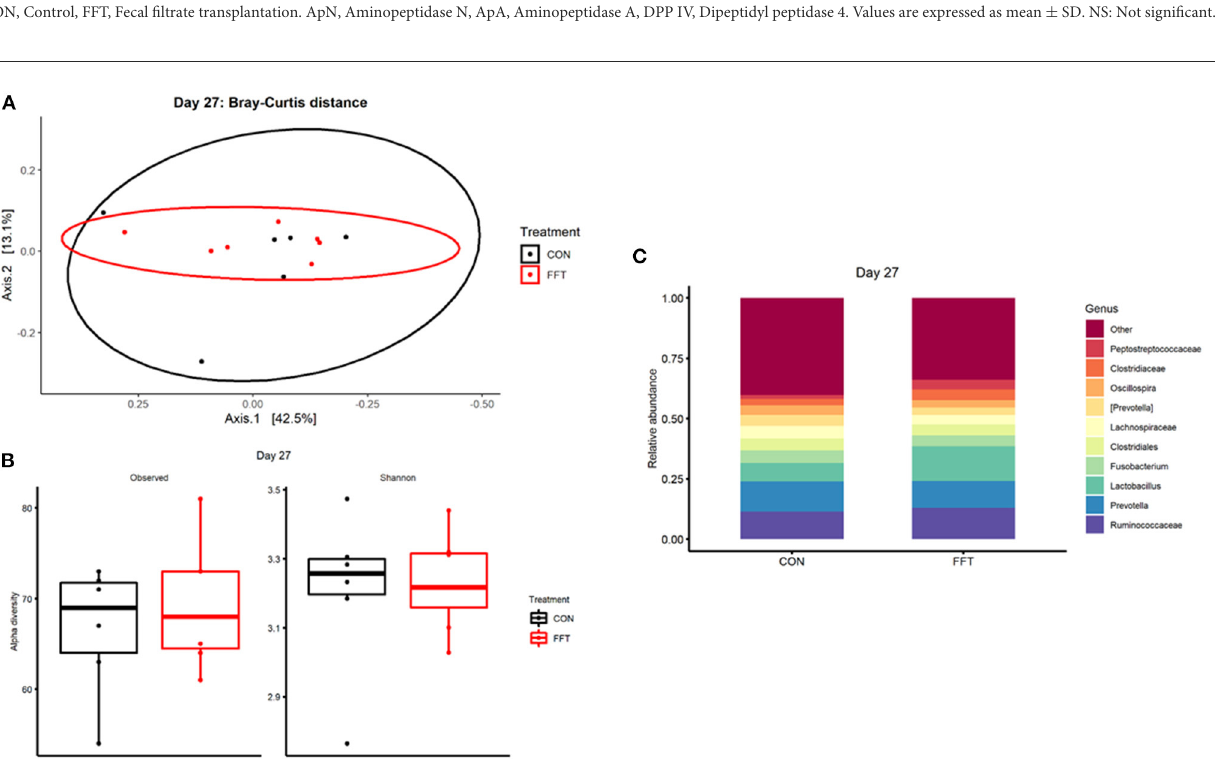
FIGURE3 Gut microbiota composition after treatment with either fecal filtrate transplantation (FFT) or sterile saline (CON). (A) Unweighted metrics-based measure of beta diversity on day 27. (B) Observed and Shannon index as a measure of alpha diversity on day 27. (C) Relative bacterial abundances from colon luminal content presented as stacked bar graphs at genus levels on day